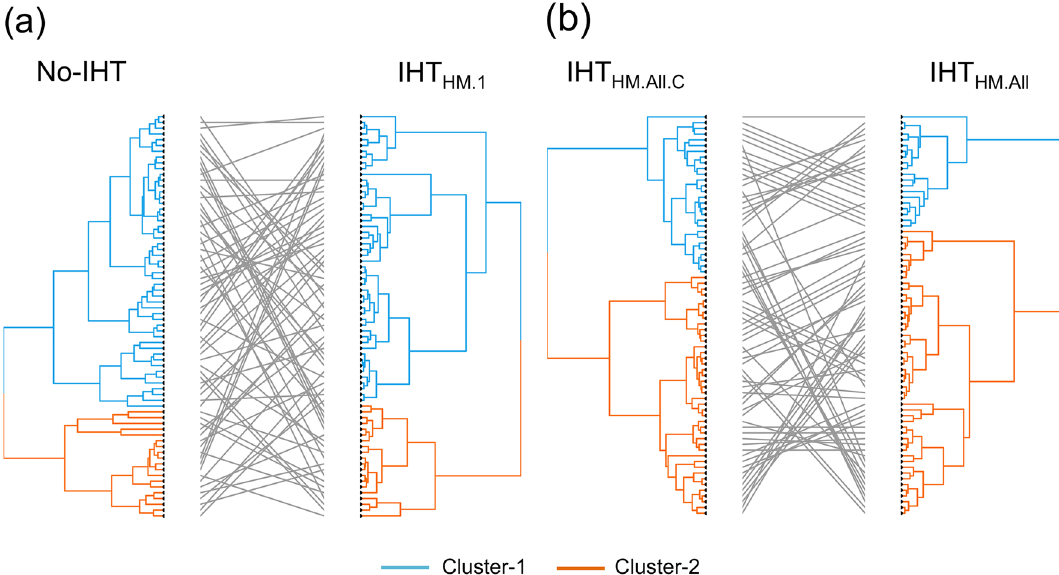
Figure 3. Comparisons of the hierarchical clustering results based on radiomics features from different datasets depending on the intensity harmonization technique (IHT) with: ( a ) the highest divergence, and ( b ) the lowest divergence. The dendrograms were obtained according to the following IHTs: histogram matching (HM) with a randomly-chosen normalized histogram of a patient (IHT HM1 ) versus no use of harmonization technique (No-IHT); and HM with the average normalized histogram of the study population (IHT HM.All ) versus IHT HM.All combined with ComBat harmonization method (IHT HM.All.C ). By convention, cluster-1 (in blue) corresponds to the group of patients with the best prognosis regarding metastatic-relapse free survival.